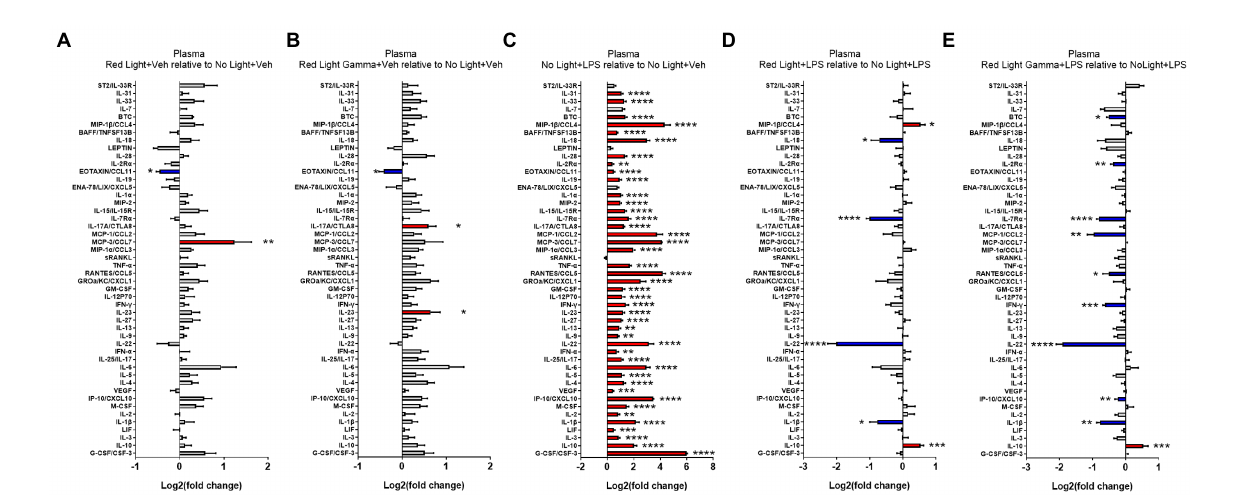
FIGURE 3 Log2 fold change of plasma cytokines measured in the Luminex assay depicts the effects of (A) red light, (B) red light gamma, and (C) LPS relative to no light + vehicle, as well as effects of (D) red light and (E) red light gamma relative to no light + LPS. Data are presented as mean ± SEM. * p < 0.05, ** p < 0.01, *** p < 0.001, **** p < 0.0001.